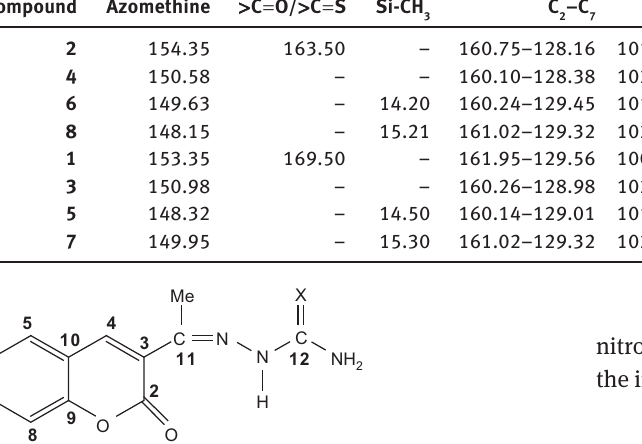
Table 2 13 C NMR ( δ , ppm) spectral data of the ligands and their corresponding complexes.